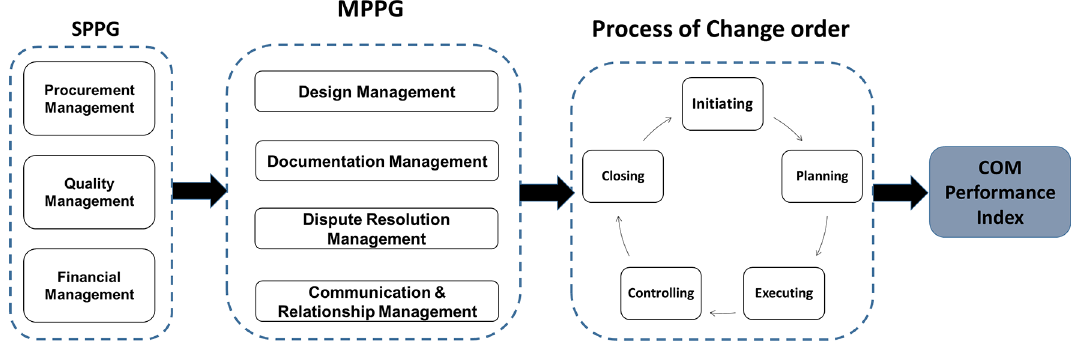
Figure 3. Operational Support System Framework (OSSF)